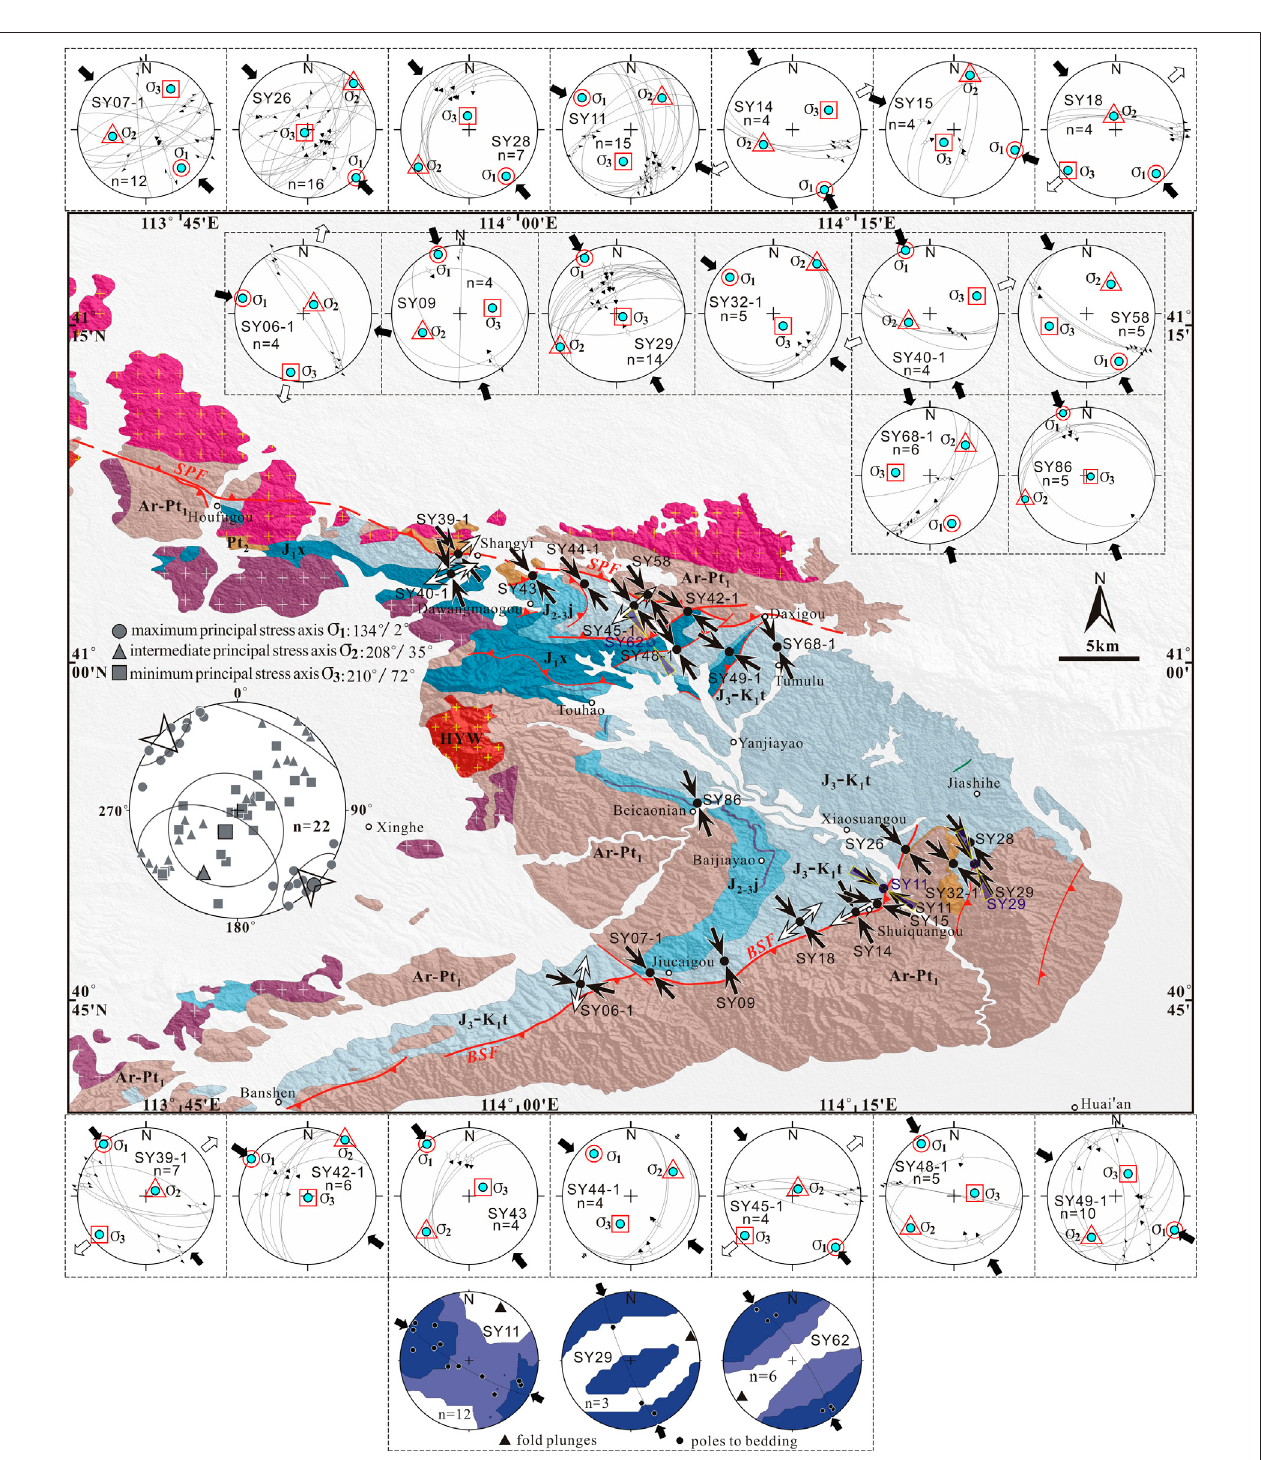
FIGURE 4 | Stereographic plots for the NW-SE compressive stress fi eld in Shangyi area, derived from analysis of fault-slip data and folds ( fi gure captions are the same as Figures 1B , 2A ). Principal stress axes ( σ 1 , σ 2 and σ 3 ) of regional stress fi eld are also shown on the map. Lower hemisphere, equal-area projections.